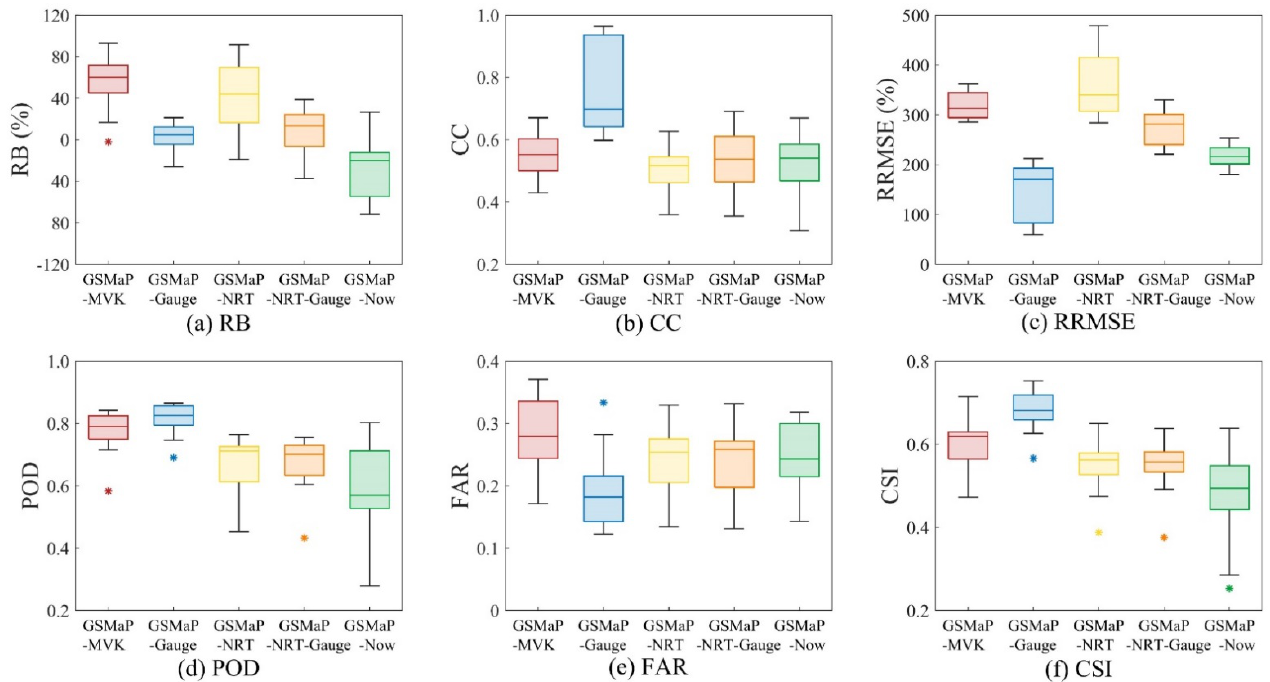
Figure 3. Box plot of the statistical indices of daily precipitation estimates from the five GSMaP SPPs at the 13 weather stations in YRSR (29 March 2017–31 December 2018).